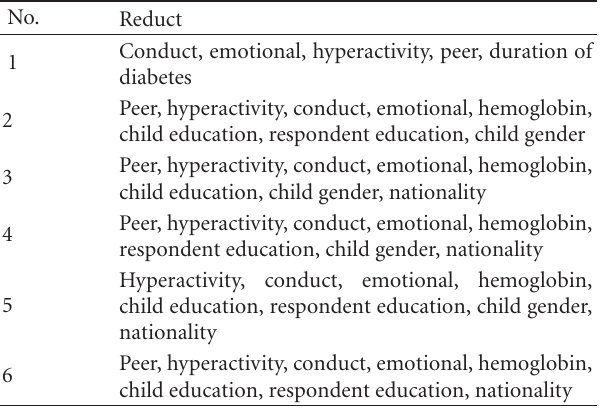
Table 7: Generated reduct sets.